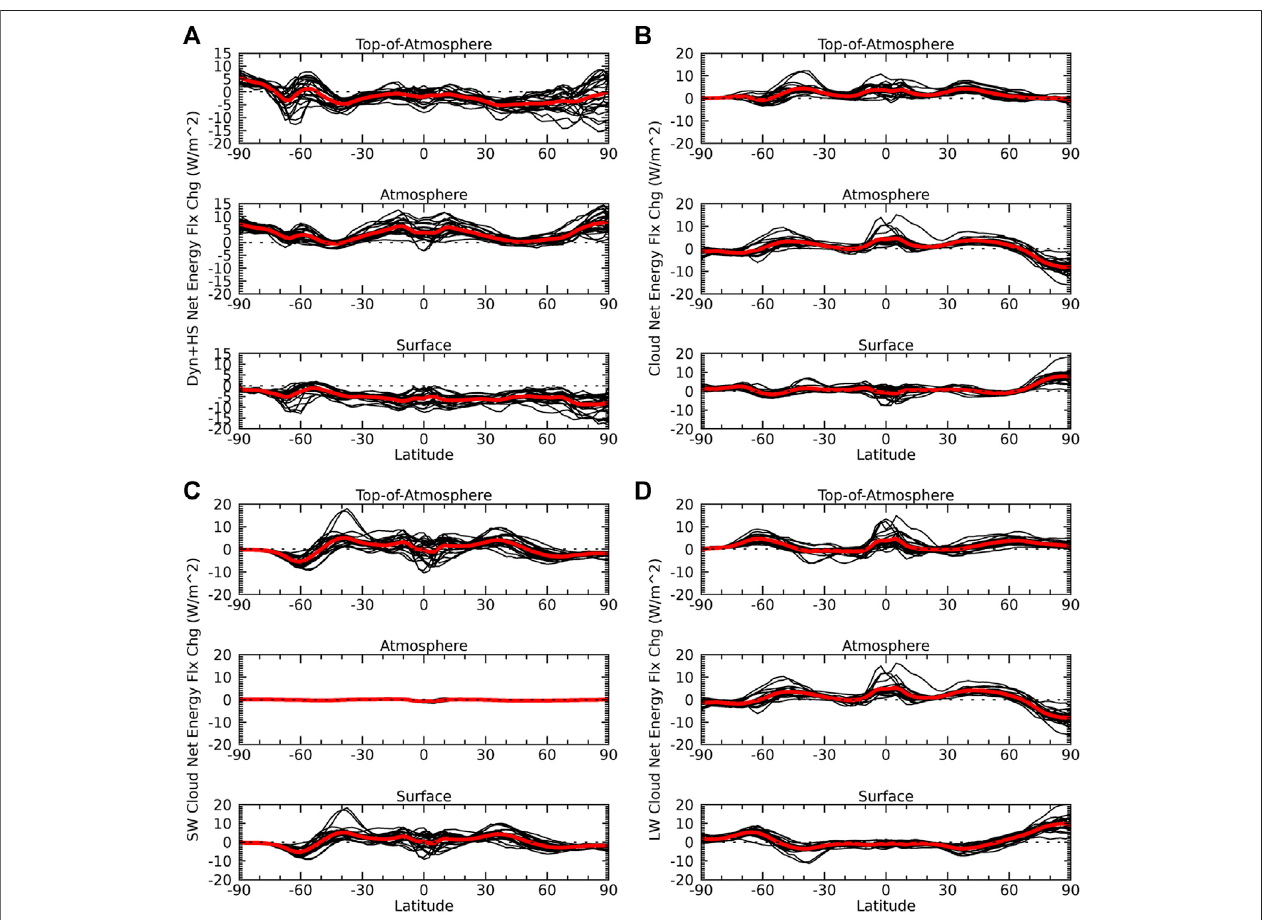
FIGURE 3 | Same as Figure 2 but due to changes in (A) dynamics plus heat storage, (B) clouds, and the (C) shortwave and (D) longwave cloud components.